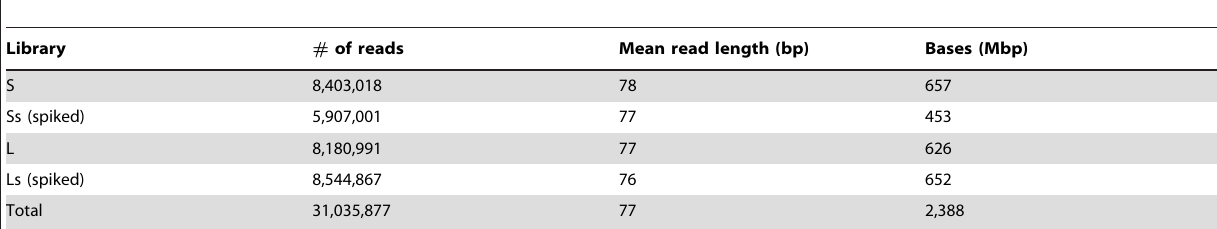
Table 1. Summary of reads generated by Illumina HiSeq2000 sequencing of four different wastewater metamobilomes.